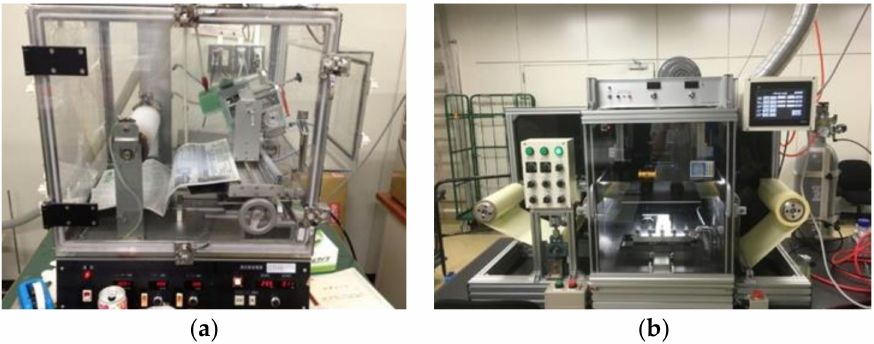
Figure 2. The lab scale electrospinning set-up ( a ) and pilot scale electrospinning set-up ( b